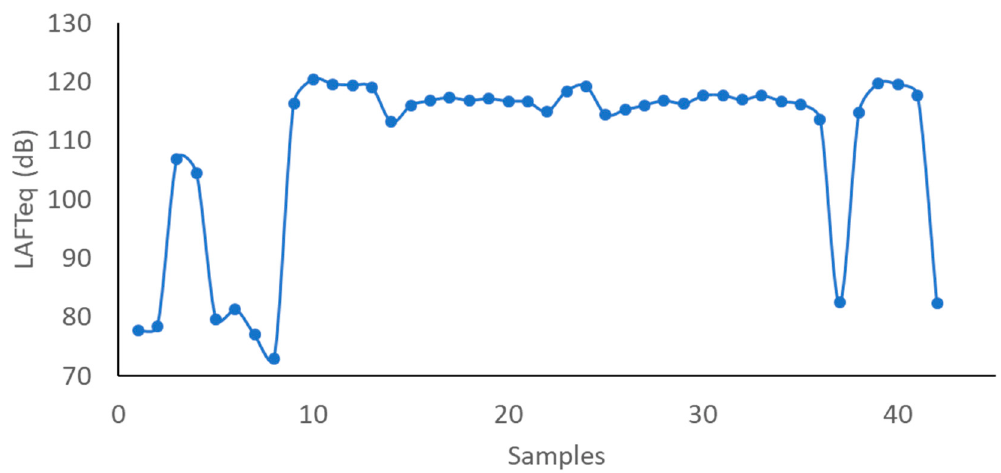
Figure 5. Evolution of the continuous sound pressure level in FAST mode (LAFTeq).